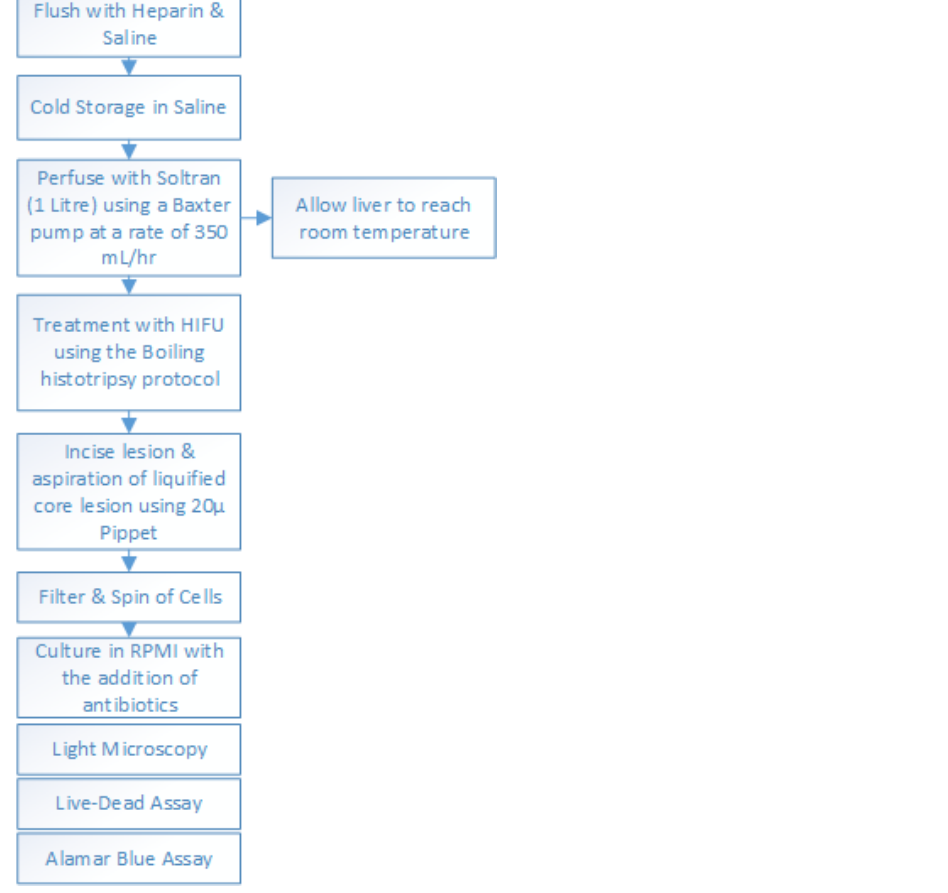
Figure 1. Experimental protocol for the hepatocyte cell isolation from perfused pig livers using HIFU device.